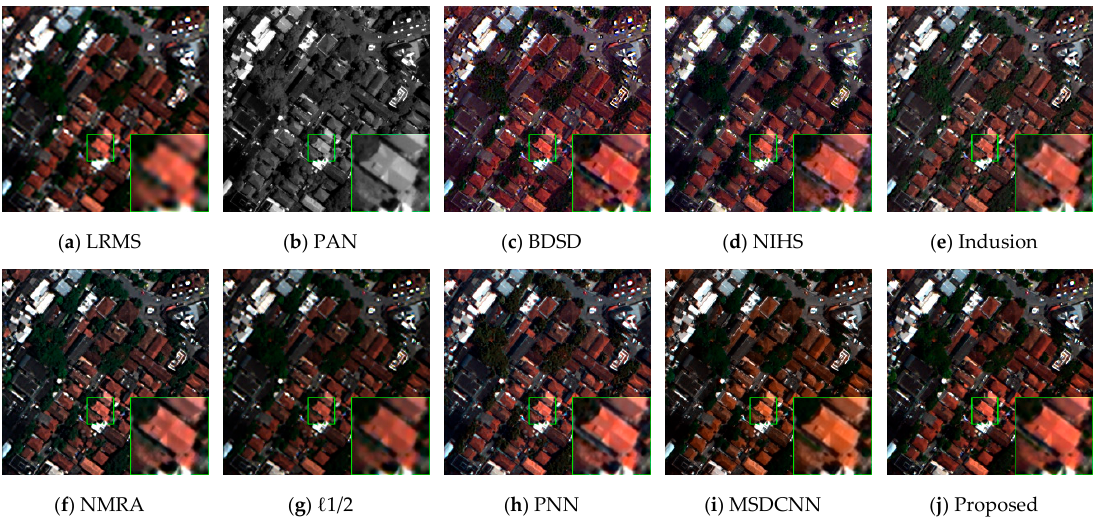
Figure 11. Results of the original scale experiment on an area extracted from a WorldView-3 image. ( a ) LRMS; ( b ) PAN; ( c ) BDSD; ( d ) NIHS; ( e ) Indusion; ( f ) NMRA; ( g ) (cid:96) 1/2; ( h ) PNN; ( i )